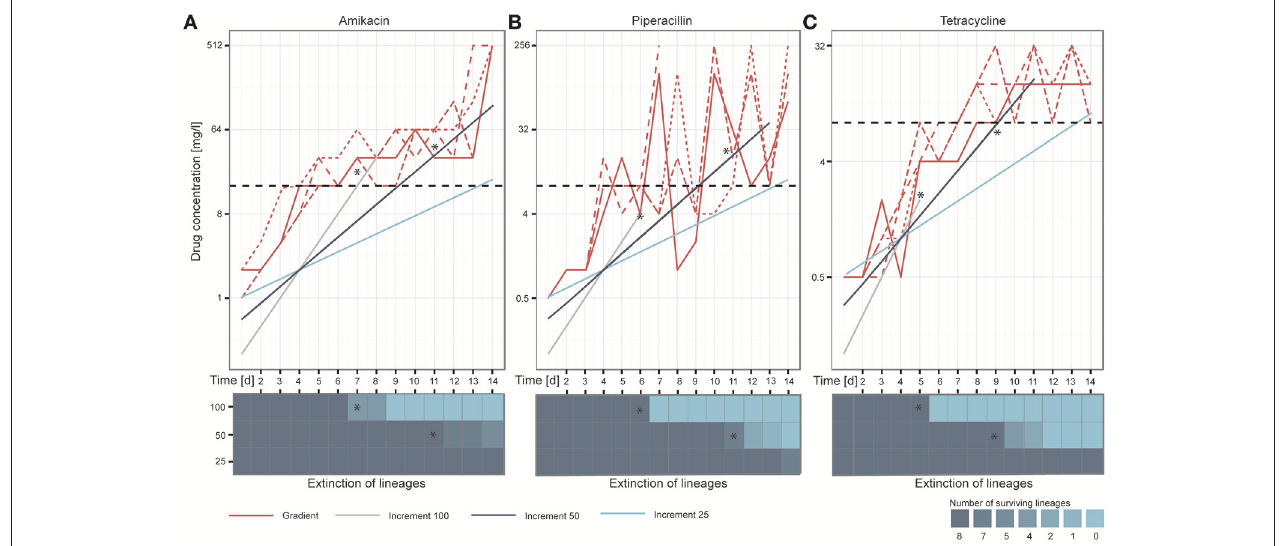
FIGURE 2 | Overview of the adaptation potential over time for each drug: (A) amikacin, (B) piperacillin, and (C) tetracycline. The lineages adapted under the gradient method follow the maximal selection pressure wherefore it can be observed that lineages from the increment approaches (100, 50, and 25) die out when they exceed the natural selection maximum defined by the gradient approach, indicated with stars in the figure. Replicates are represented in different line styles. The clinical breakpoint is indicated with a dotted line in black. The heatmaps illustrate the extinction of lineages over time.